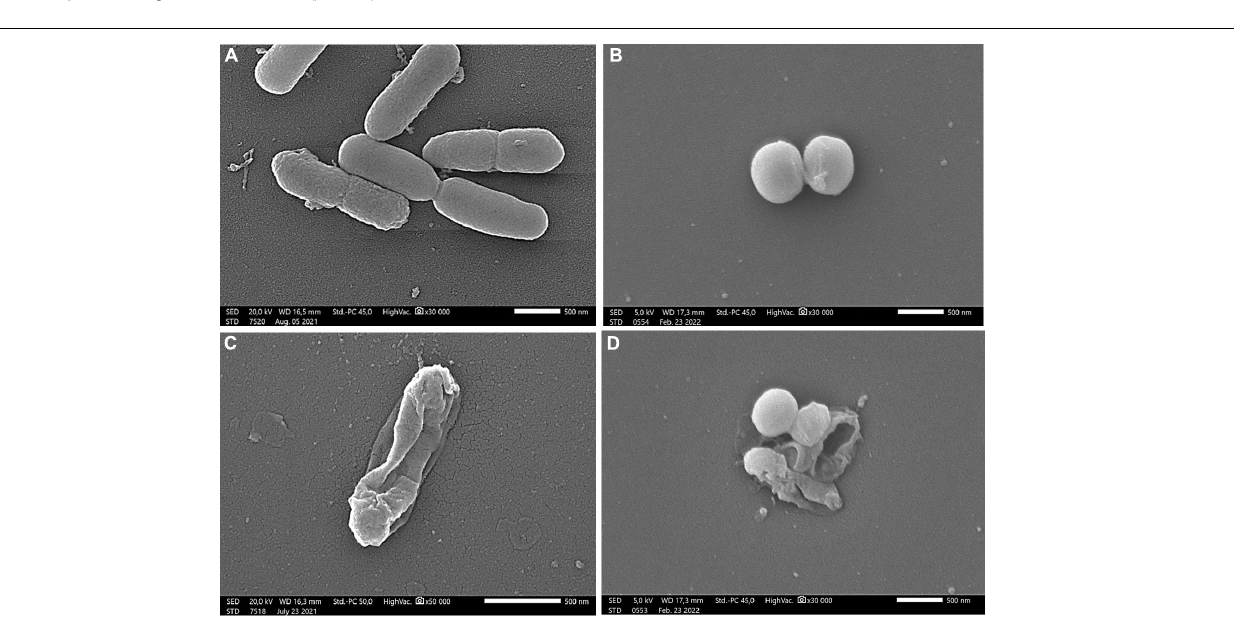
degradation was detected at 90 min, in case of linden and